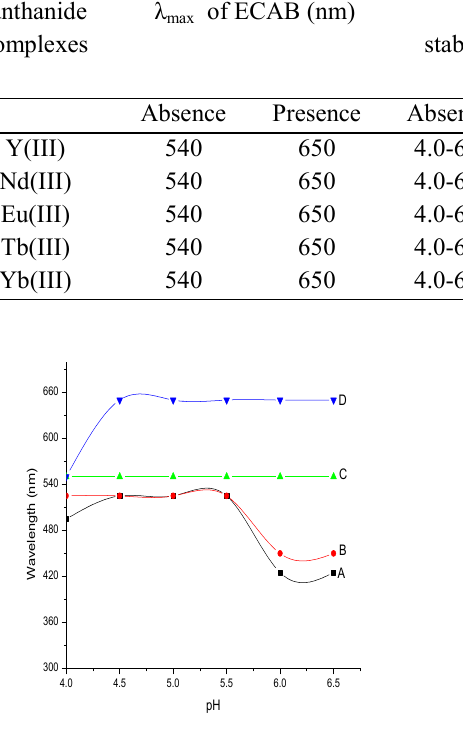
Figure 8. Variation in λ pH of: A [ECAB]-(Reagent), B [ECAB+CDMEAB]-(Modified reagent), C [ECAB+Eu(III)-(Binary complex), D [ECAB+CDMEAB+Eu(III)- (Ternary